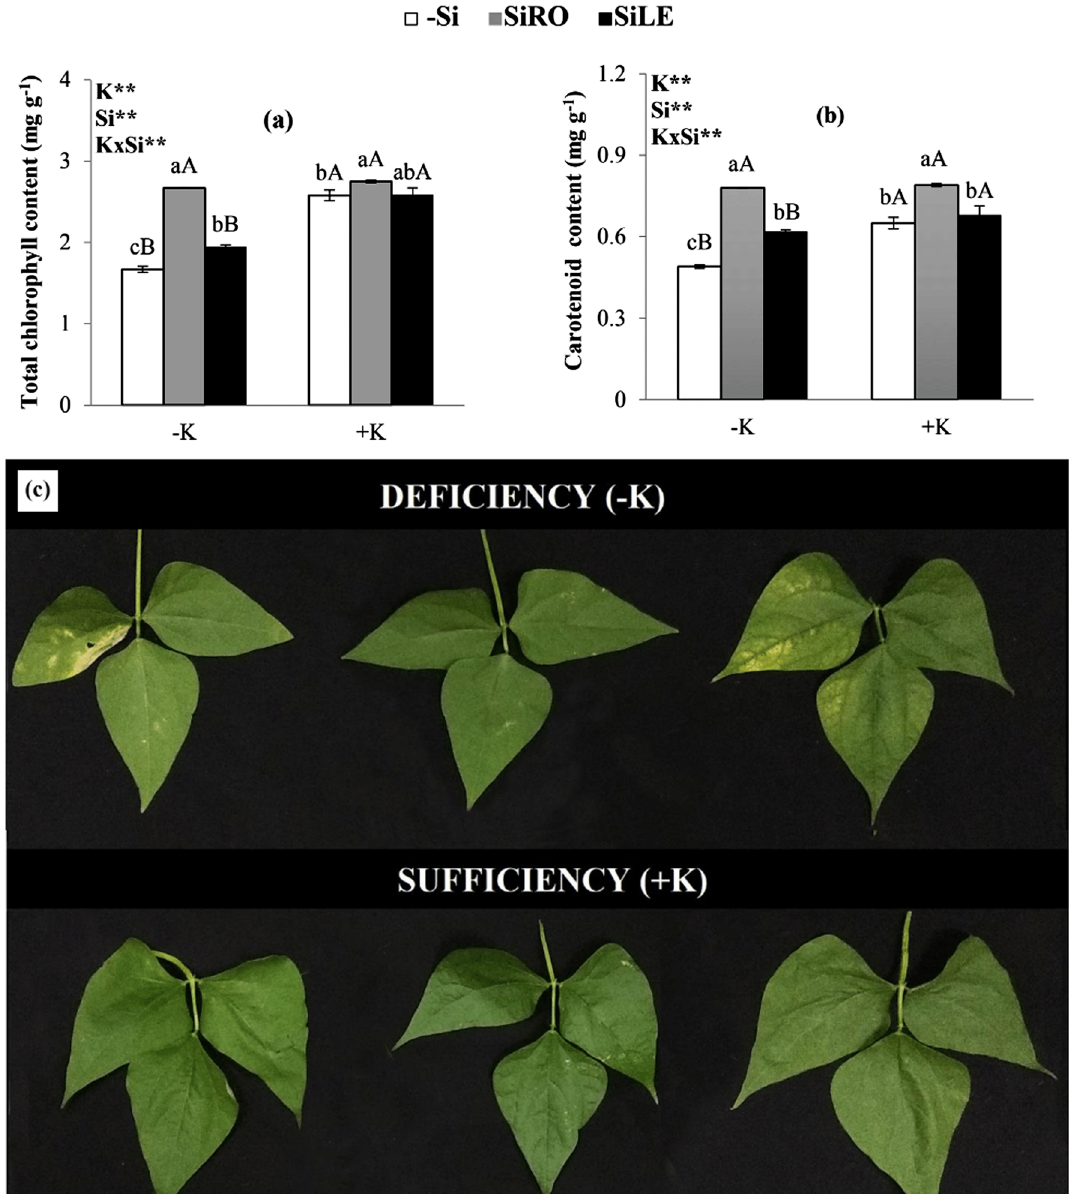
Figure 3. Total chlorophyll content ( a ), carotenoid content ( b ) and chlorosis in oldest leaves ( c ) of bean plants cultivated in a hydroponic system under deficiency (–K) and sufficiency (+K) of K, with Si supplied via nutrient solution (root) (SiRO), leaf spraying (SiLE), and control (–Si). The error bars in the figures represent standard error. Different letters, lower case between the supply of Si in the same concentration of K, and upper case between concentrations of K in the same form of supply of Si, indicate differences (P < 0.05, Tukey’s test) between